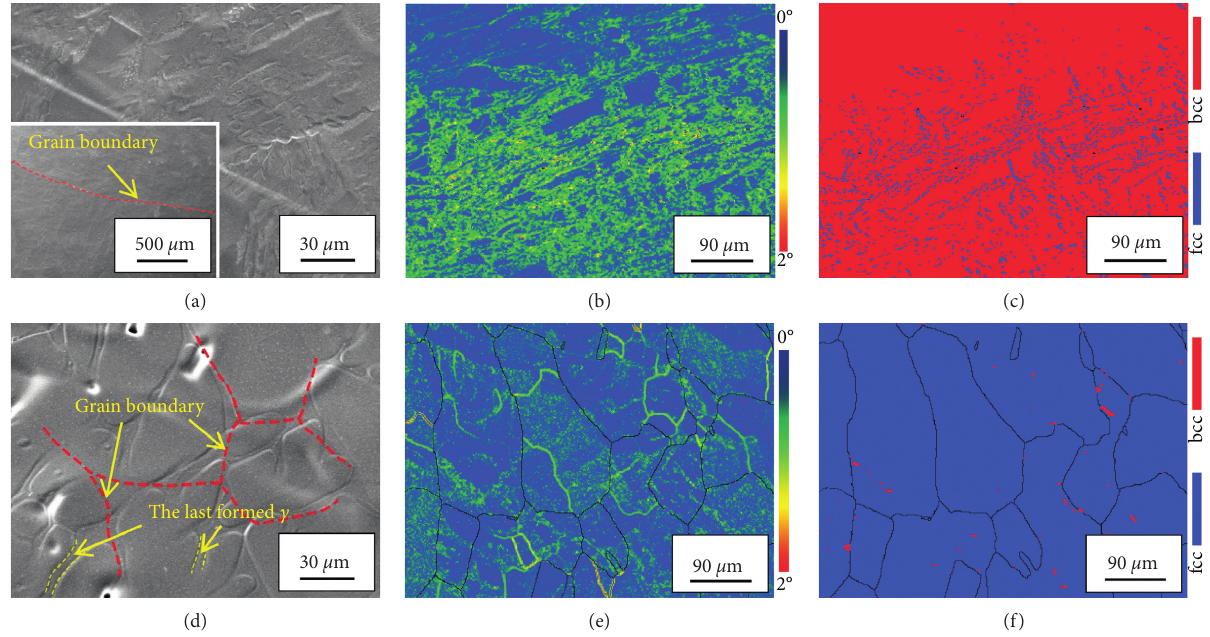
Figure 6: Surface structure and EBSD analysis results: (a) surface structure of sample A; (b) LocMis map of sample A; (c) phase map of sample A; (d) surface structure of sample N; (e) LocMis map of sample N; (f) phase map of sample N.